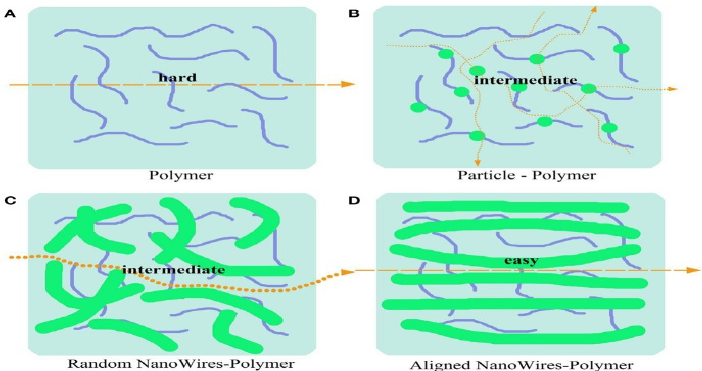
Figure 13. Schematic diagram of ion transport mechanism in SPEs incorporated with different varieties of ceramic fillers. ( A ) Ion transfer pathway in the pure polymer. ( B – D ) Ion transfer pathway in nanoparticle-polymer-based CPEs ( B ), random nanowires ( C ), and aligned nanowires ( D ) [99].